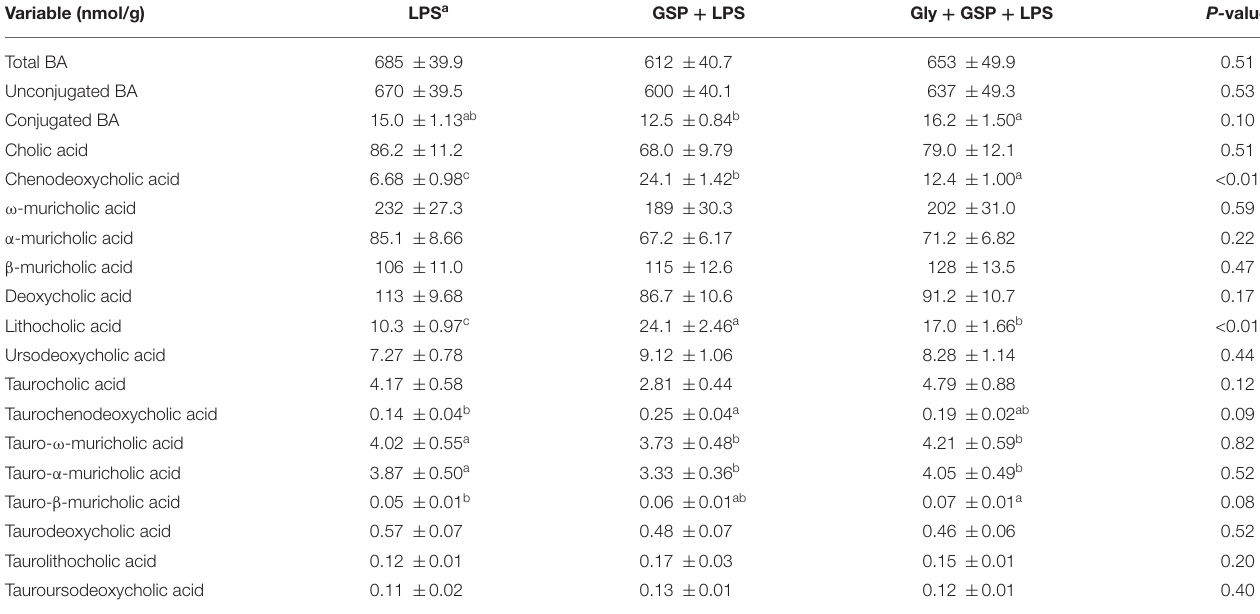
TABLE 4 | Fecal BAs profiles of mice in Experiment